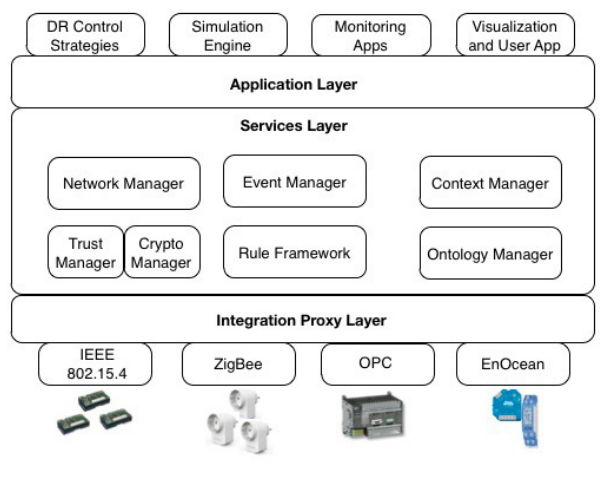
Figure 2. Schema of SEEMPubS